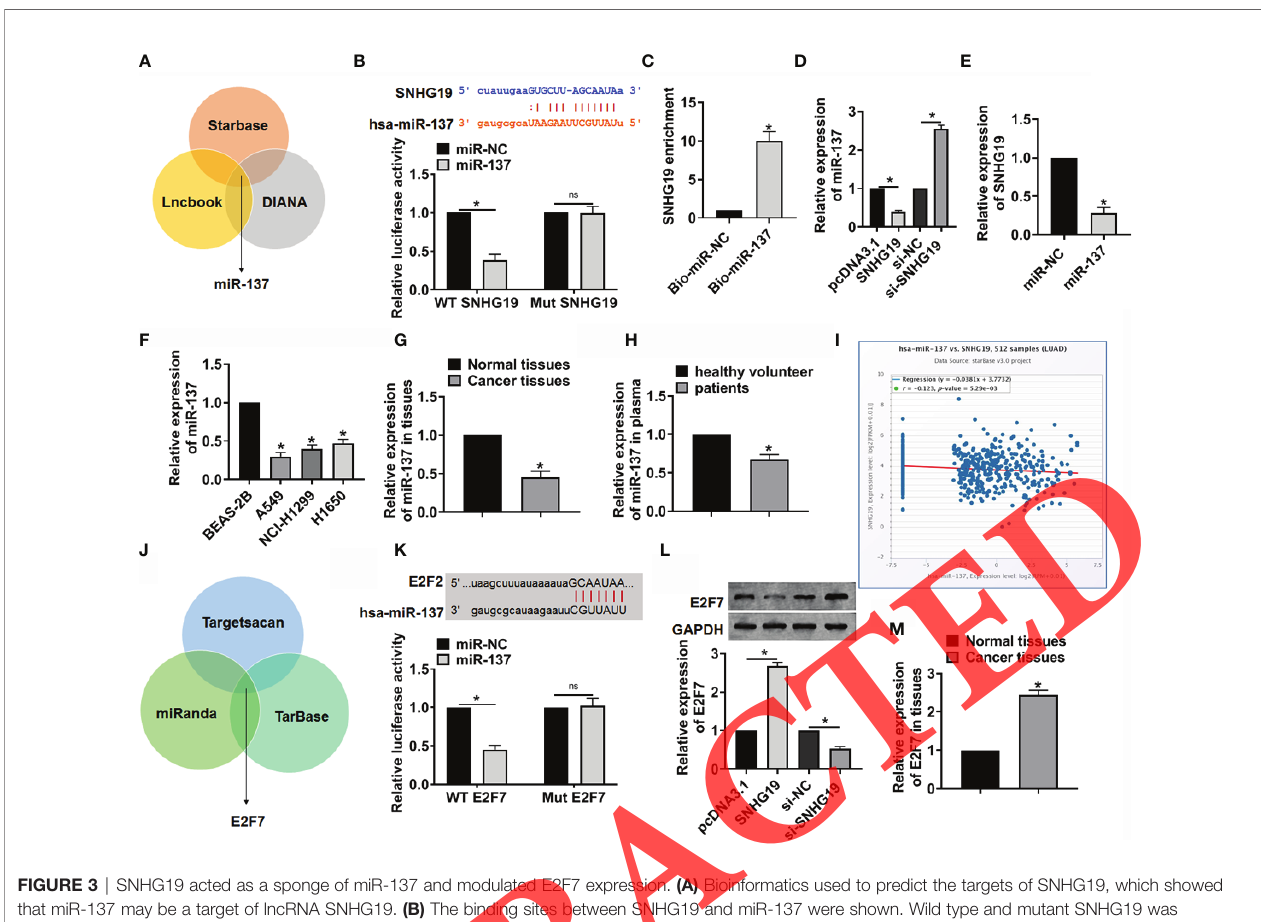
FIGURE 3 | SNHG19 acted as a sponge of miR-137 and modulated E2F7 expression. (A) Bioinformatics used to predict the targets of SNHG19, which showed that miR-137 may be a target of lncRNA SNHG19. (B) The binding sites between SNHG19 and miR-137 were shown. Wild type and mutant SNHG19 was transfected into HEK293 cells with or without miR-137, and luciferase assay was to evaluate the binding between miR-137 and SNHG19. (C) RIP used to determine the binding between SNHG19 and miR-137 in A549 cells. (D) A549 cells were transfected with SNHG19 plasmid or si-SNHG19 or its NC, the mRNA level of miR- 137 was detected using qRT-PCR. (E) A549 cells were transfected with miR-137/miR-NC, and SNHG19 expression was tested. The level of miR-137 in NSCLC cell lines (F) , patient ’ s tissues (G) and plasma (H) was detected. (I) ENCORI website used to determine the correlation between SNHG19 and miR-137 in lung adenocarcinoma (LUAD). (J) Bioinformatics used to predict the targets of miR-137. (K) The binding sites between E2F7 and miR-137 were shown. Wild type and mutant E2F7 was transfected into HEK293 cells with or without miR-137, and luciferase activity was tested. (L) A549 cells were transfected with SNHG19 plasmid or si-SNHG19 or its NC, the protein level of E2F7 was detected using western blot. (M) E2F7 expression in normal and cancerous tissues was detected. Data are mean ± SD; *P < 0.05, ns, no statistical signi fi cance. All experiments were repeated three